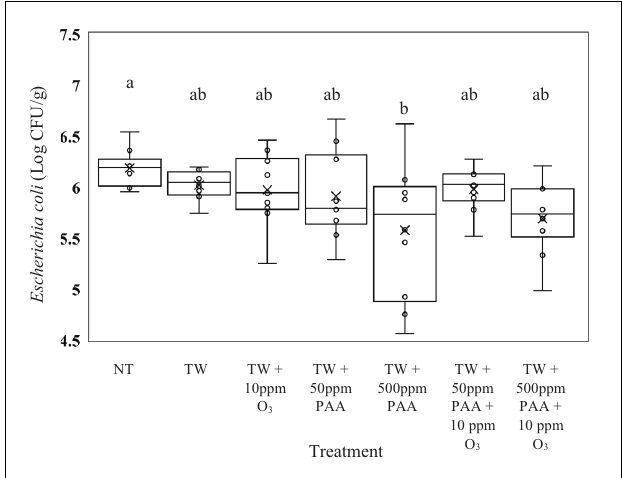
FIGURE 2 | The effect of applying PAA alone and in combination with aqueous ozone at 10 ppm on the mean log CFU/g of Escherichia coli J53 on whole hen carcasses 1 , 2 . Carcasses were inoculated with 10 7 CFU/mL of E. coli for a final attachment of 10 6 CFU/g of E. coli J53. Birds were then placed in a modified spray cabinet to be treated for 5 s (4 × ) via a low pressurized spray. Immediately after, birds were rinsed in 400 mL of nBPW and subsequently plated to determine load of E. coli . 1 N = 68, n = 10, P = 0.0126. 2 Means with different superscripts are considered significantly different (a,b).